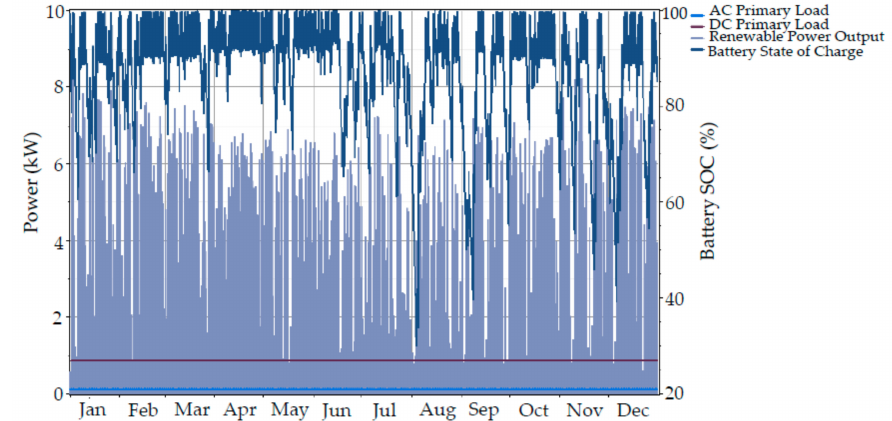
Figure 10. The average hourly power contribution of the PV array and battery